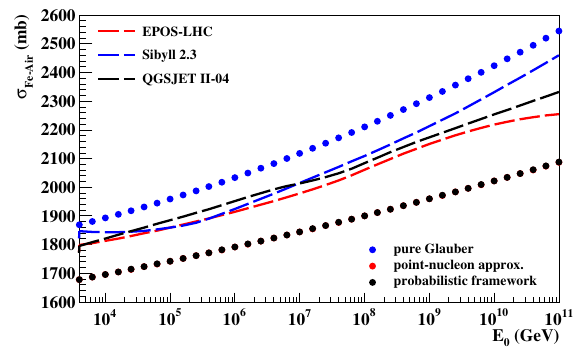
Figure 2. Fe-Air inelastic cross-section calculated using Glauber theory, point-nucleon approximation and probabilistic frame- work.